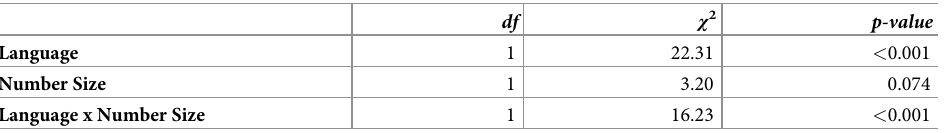
Table 4. Results of the verbal-visual matching task’s CR’s linear mixed